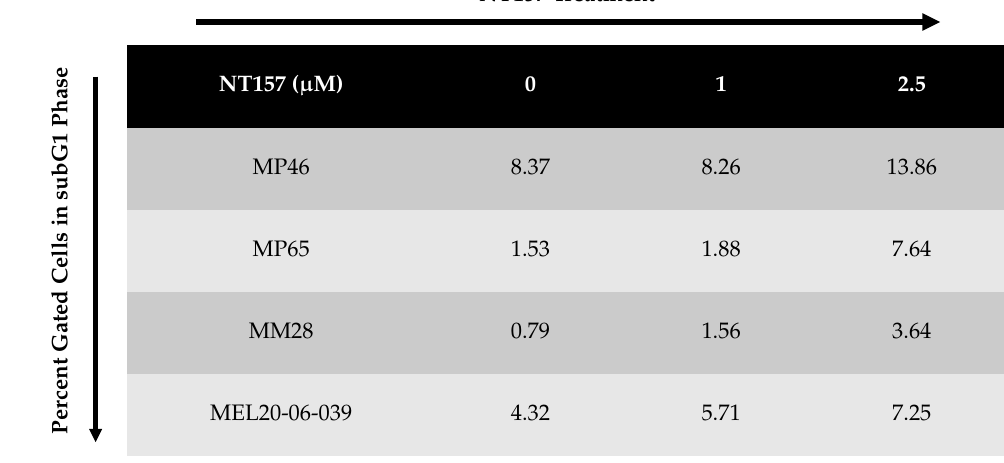
(Figure S2). We again observed varied sensitivities to NT157 among the cell lines tested. We also observed that NT157 induces apoptosis in UM cells, as evident from the dose-dependent increase in the subG1 population upon NT157 treatment, observed through FACS analysis after propidium iodide staining (Figure 2F and Table 1). To characterize whether this G0/G1 cell accumulation is due to apoptosis, we performed molecular analysis of the apoptotic marker using western blotting. We observed increased levels of PARP processing (cleaved PARP induction) as well as caspase 3 processing (reduction in caspase 3 protein levels) after NT157 treatment of UM cell lines (Figure 2G, see full western blot images in Supplementary Materials). Table 1. Shows percent cells gated in subG1 phase with /without treatment with NT157 . The percent of cells in cell cycle phases was obtained by counting propidium iodide-stained cells after 48 h of NT157 treatment. At the higher NT157 concentration we see an accumulation of subG1 cells compared to the untreated controls.